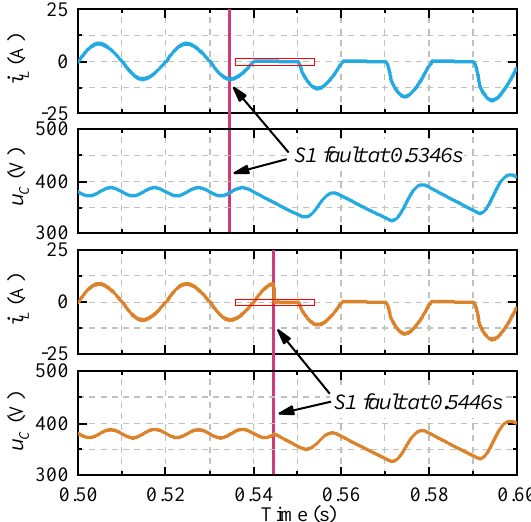
Figure 3. Input current and capacitor voltage waveforms at the time of S1 fault in positive and negative cycles.